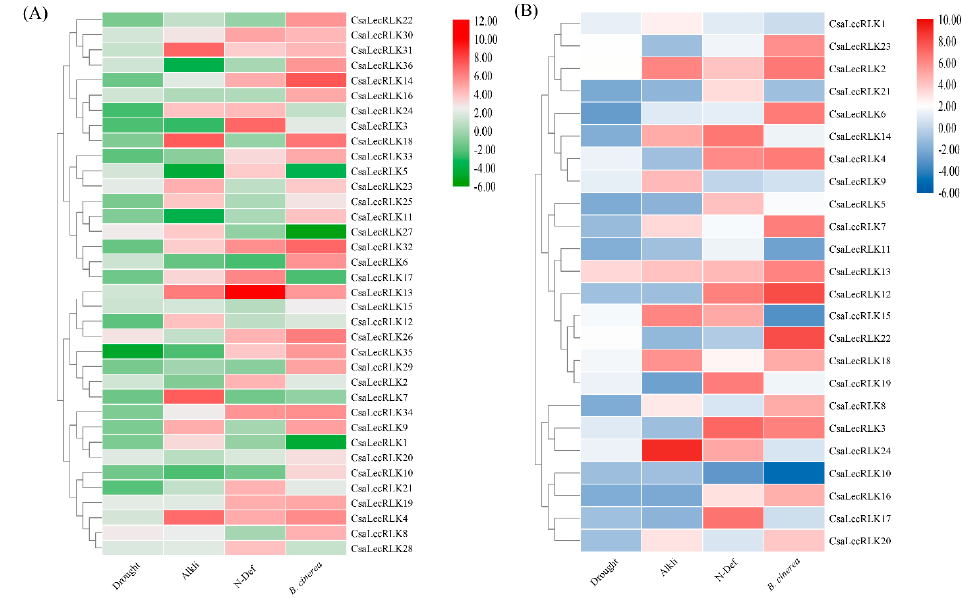
Figure 7. RNA-sequencing data on biotic ( Botrytis cinerea ), and abiotic (drought, alkali, and nitrogen deficiency) stresses for both G-type ( A ) and L-type ( B ) CsaLecRLKs. The heatmap was generated on the Log2 of RPKM values using Rstudio (A package of R, USA).